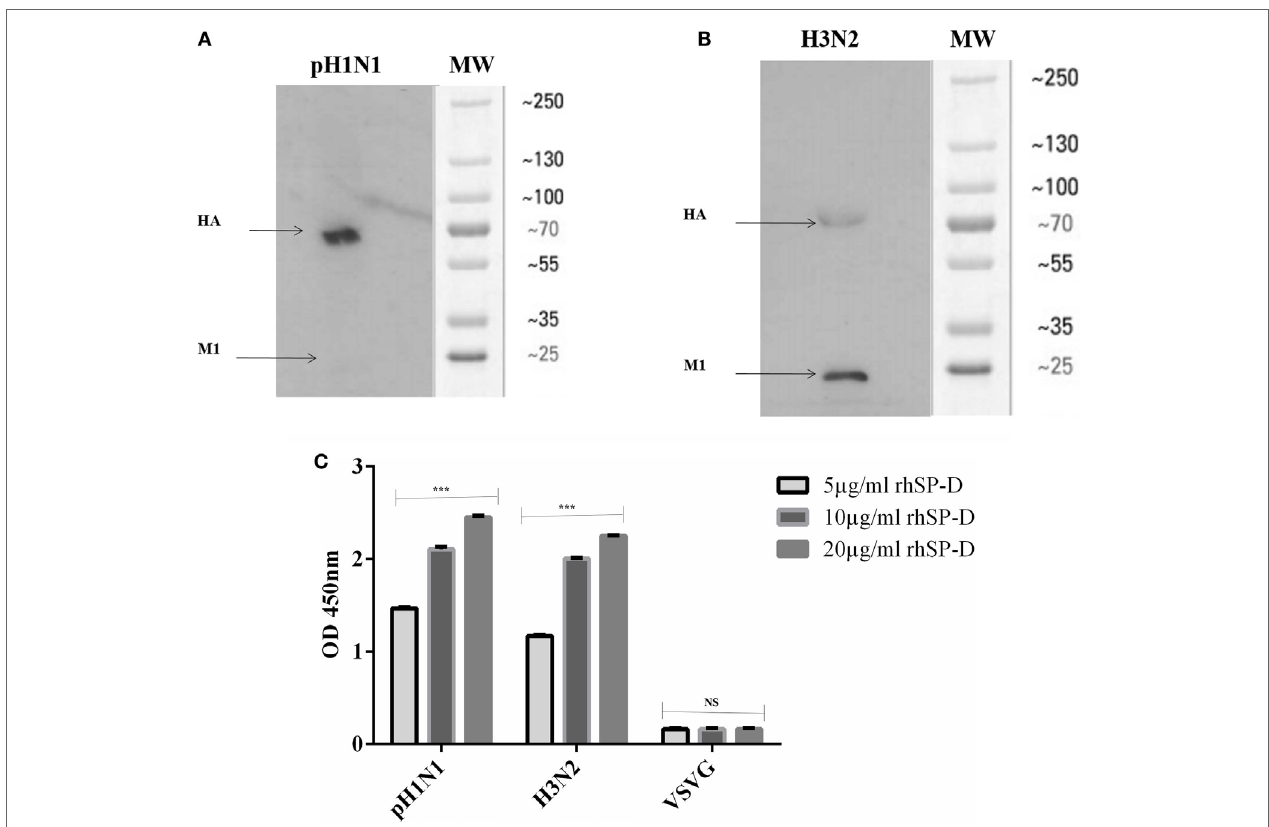
FigUre 4 | Far western blot analysis to show rfhSP-D binding to purified (a) pH1N1 and (B) H3N2: 10 μ l of concentrated virus (1.36 × 10 6 pfu/ml) was first run on the SDS-PAGE under reducing conditions, and then transferred onto a nitrocellulose membrane and incubated with 5 µg of rfhSP-D. The membrane was probed with anti-rabbit SP-D polyclonal antibodies. rfhSP-D bound to HA (70 kDa) and M1 (27 kDa) in the case of both pH1N1 and H3N2 subtypes. (c) ELISA to show the binding of rfhSP-D to purified recombinant hemagglutinin (HA) ( μ g/ml). VSV-G was used as a negative control. The data were expressed as mean of three independent experiments carried out in triplicates ± SEM. Significance was determined using the unpaired one-way ANOVA test (*** p < 0.0001) ( n =